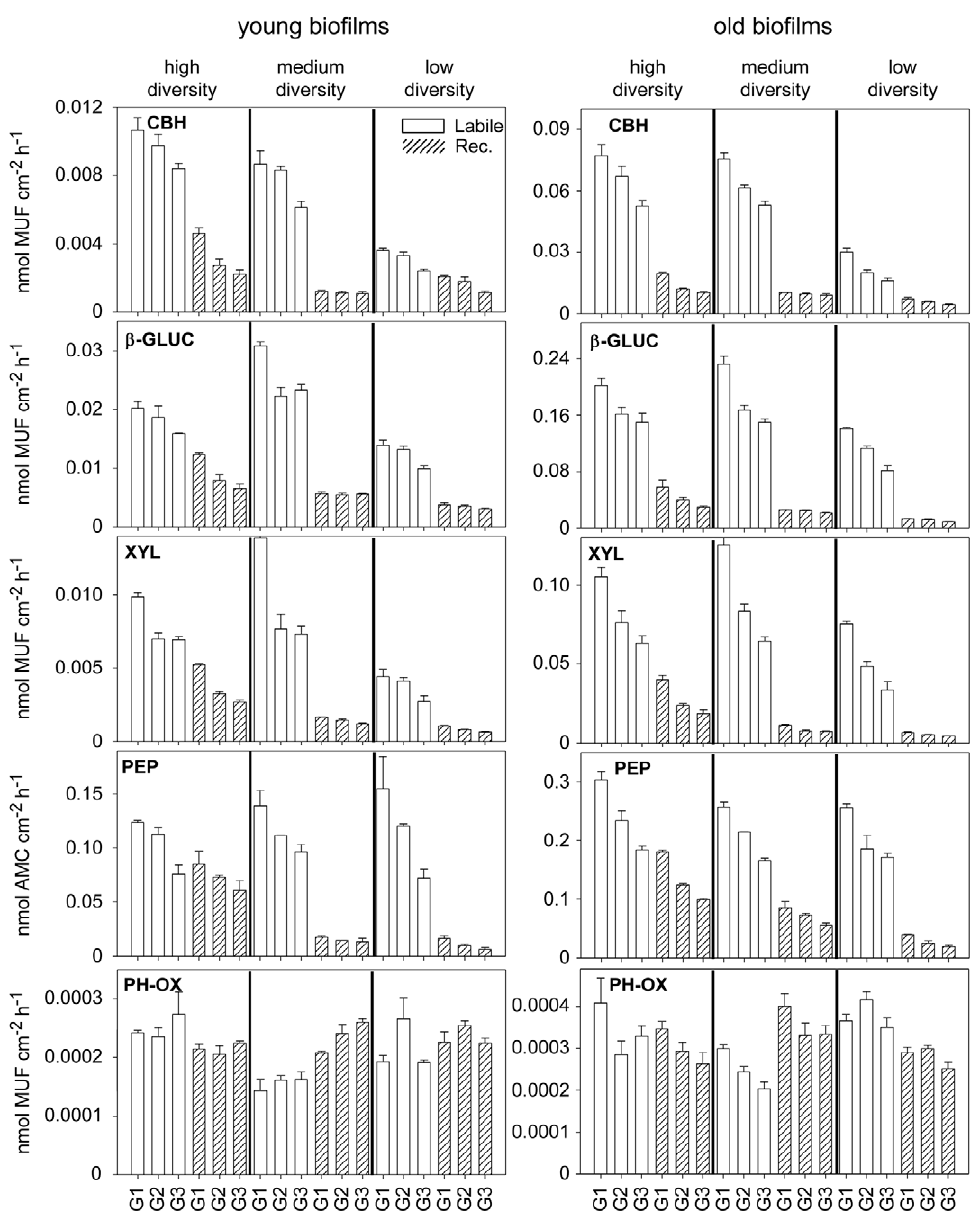
Figure 2. Overview of extracellular enzymatic activities in the different treatments at two sampling occasions (young and old biofilms, respectively). For each level of diversity the labile (white bars) and recalcitrant (hatched bars) treatments are for samples from the inflow (G1), mid section (G2) and outflow (G3) of each bioreactor. Mean 6 s.e.m bars were shown, N=3. Abbreviations: CBH: cellobiohydrolase, ß-GLUC: beta-glucosidase, XYL: xylosidase, PEP: leucine-aminopeptidase, PH-OX: phenoloxidase.